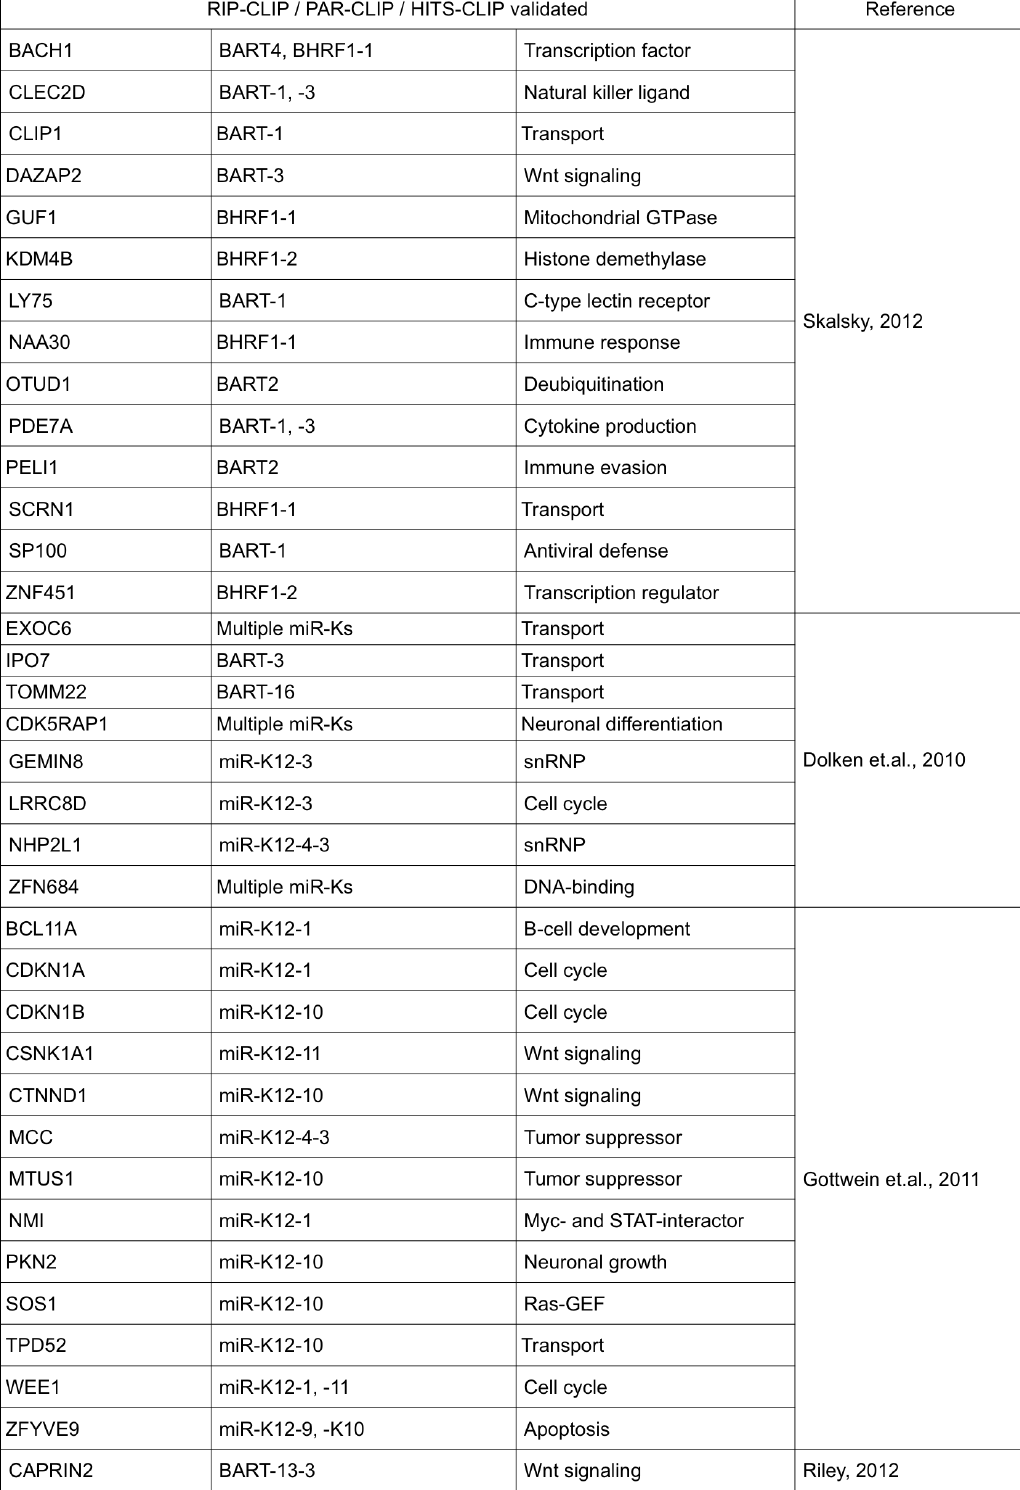
Table 2. Validated targets from high-throughput studies. Shown are cellular targets identified by photoactivatable ribonucleoside enhanced crosslinking and immunoprecipitation (PAR-CLIP), High-throughput sequencing of RNA isolated by crosslinking immunoprecipitation (HITS-CLIP) or RNA immunoprecipitation and microarray (RIP-Chip) techniques. Validation of these targets was done using luciferase reporter